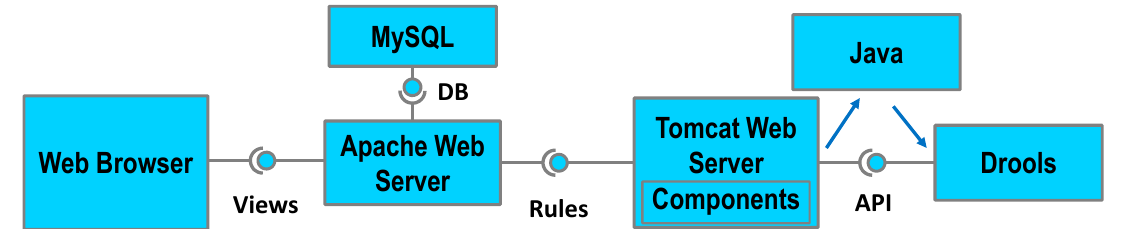
Figure 5. System architecture that integrates Drools into the workflow.